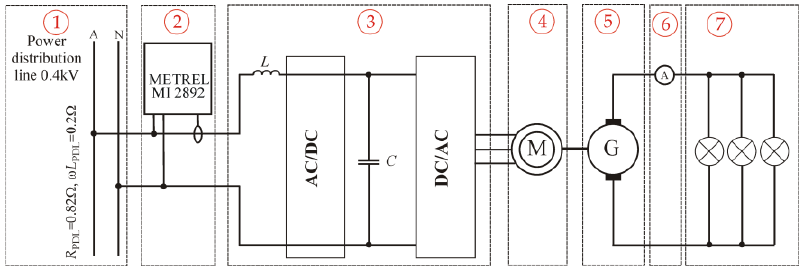
Figure 15. Circuit diagram of experimental setup for the reactive power provided or drawn out by Siemens Micromaster 420 single-phase diode rectifier supply-side VFD analysis.